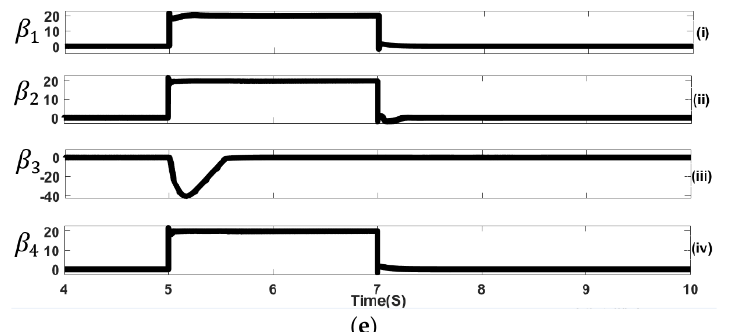
Figure 11. Second case study: ( a ) 𝑣 𝑖 , ( b ) 𝐼 𝑜𝑢𝑡 𝑖 , ( c ) %𝑉𝑒 𝑖 , ( d ) %𝐼𝑐 𝑖 , and ( e ) voltage cyber-attack miti- gation signals for DGUs, 𝛽 i .